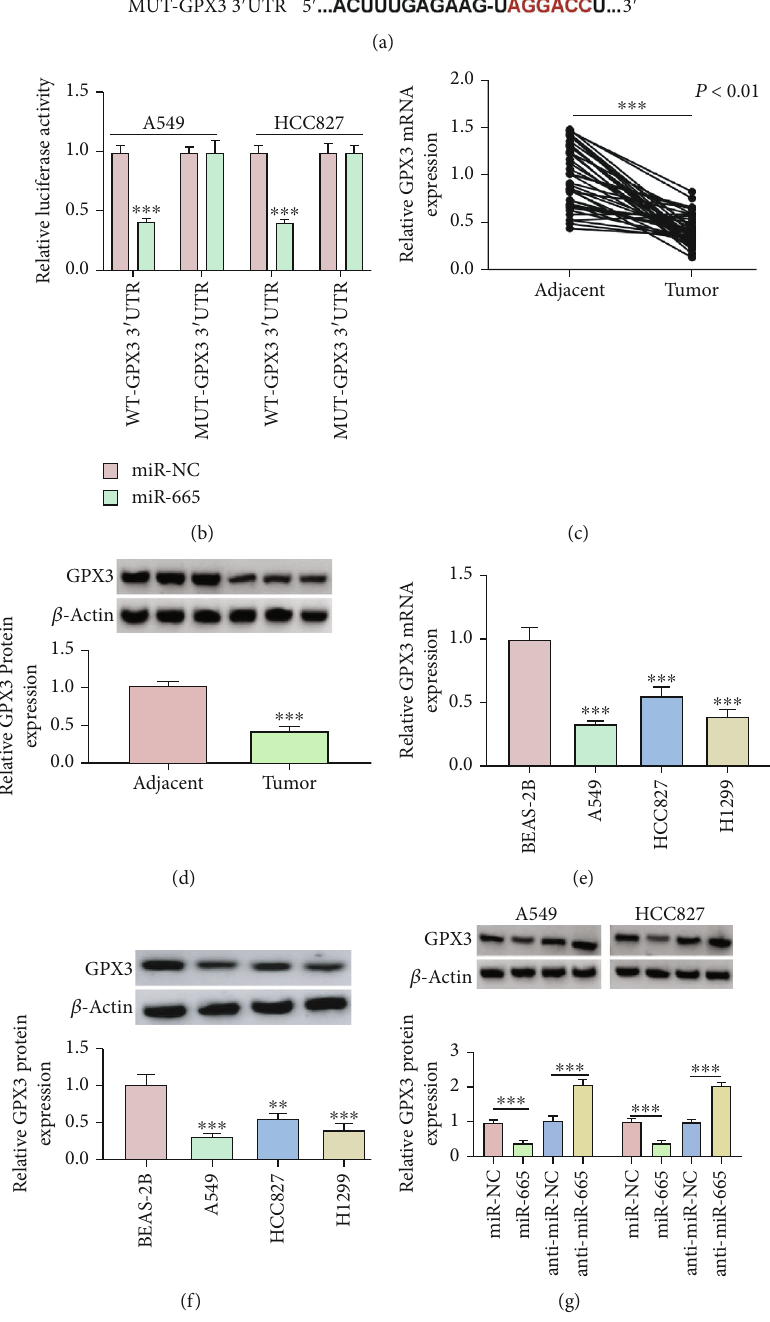
Figure 5: GPX3 is the direct target of miR-665. (a) The complementary sequences between miR-665 and GPX3 were shown. (b) Dual- luciferase reporter assays were performed to con fi rm the association between miR-665 and GPX3 3 ′ UTR. (c, e) The expression of GPX3 in NSCLC tissues ( n = 40 ) and cells was tested by qRT-PCR. (d, f) Western blot examined the protein level of GPX3 in NSCLC tissues ( n = 40 ) and cells. (g) Western blot was used to detect the expression of GPX3 in transfected A549 and HCC827 cells. ∗∗∗ P < 0 : 001